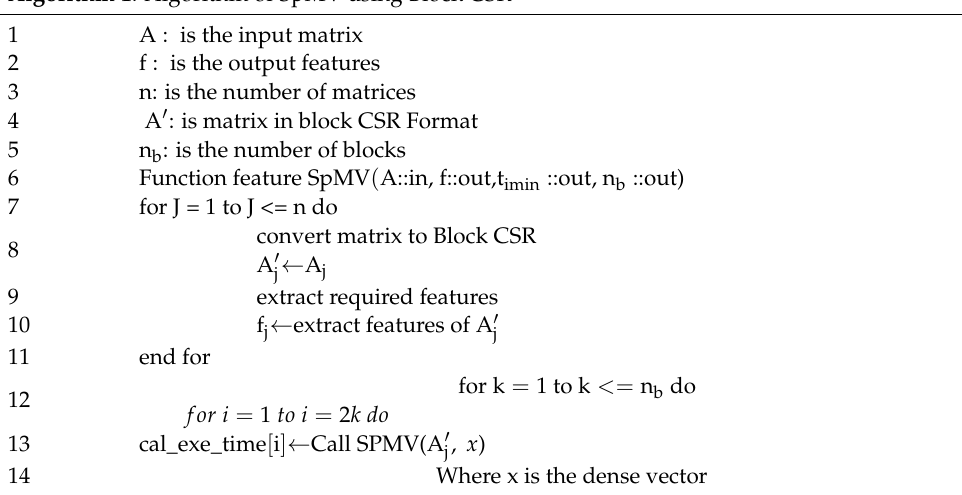
Algorithm 1 : Algorithm of SpMV using Block CSR